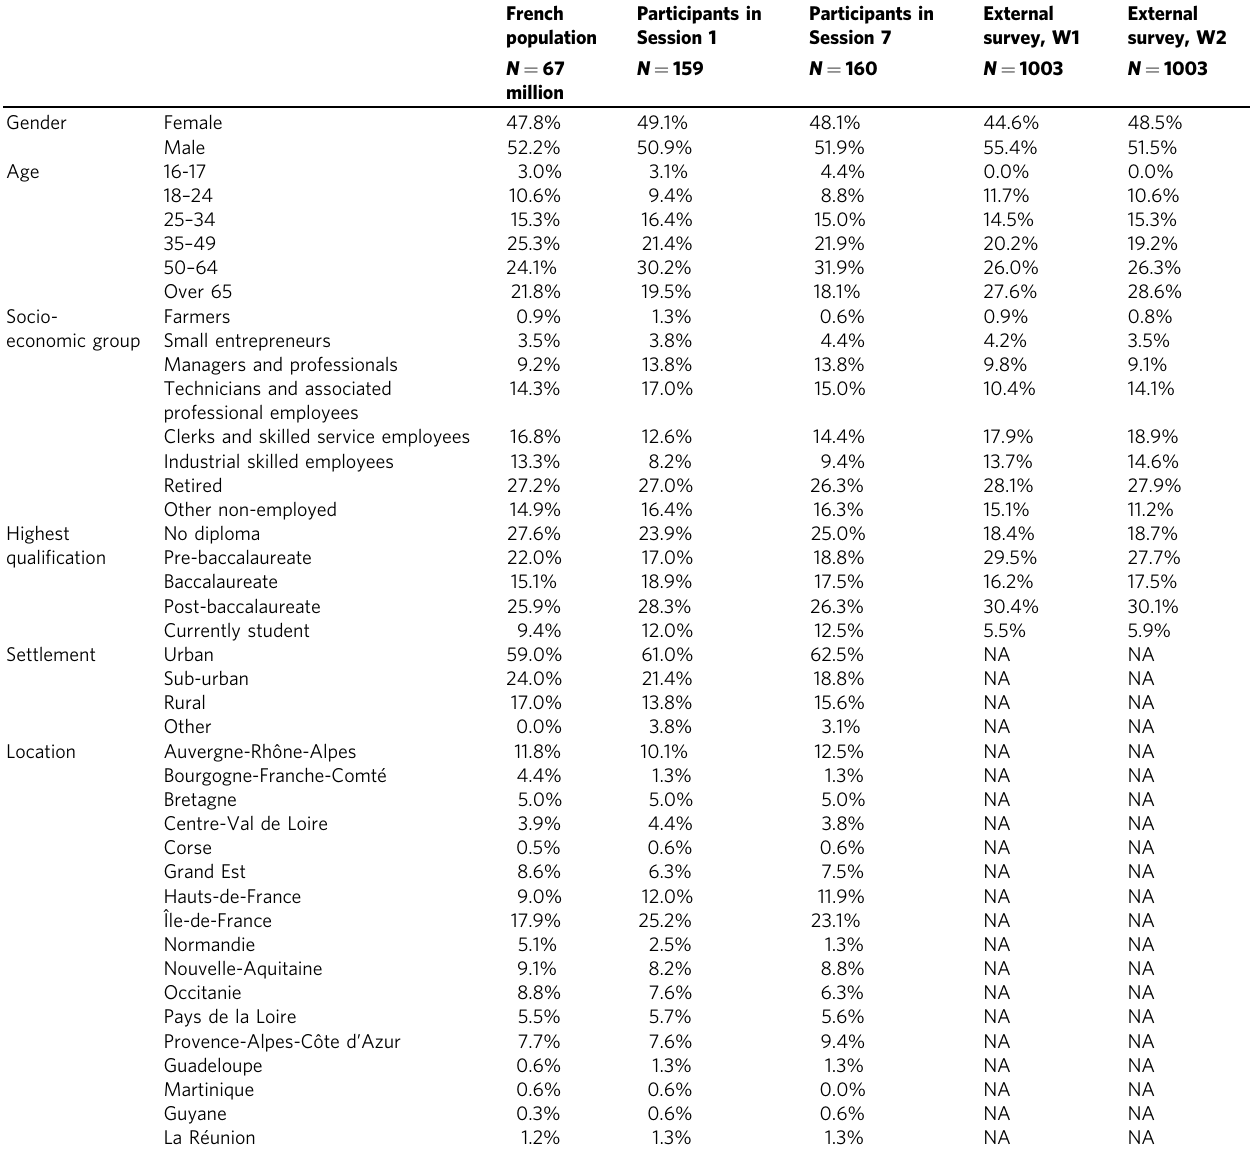
Table 1 Composition of the CCC and of the respondents to the external survey ( fi rst and second